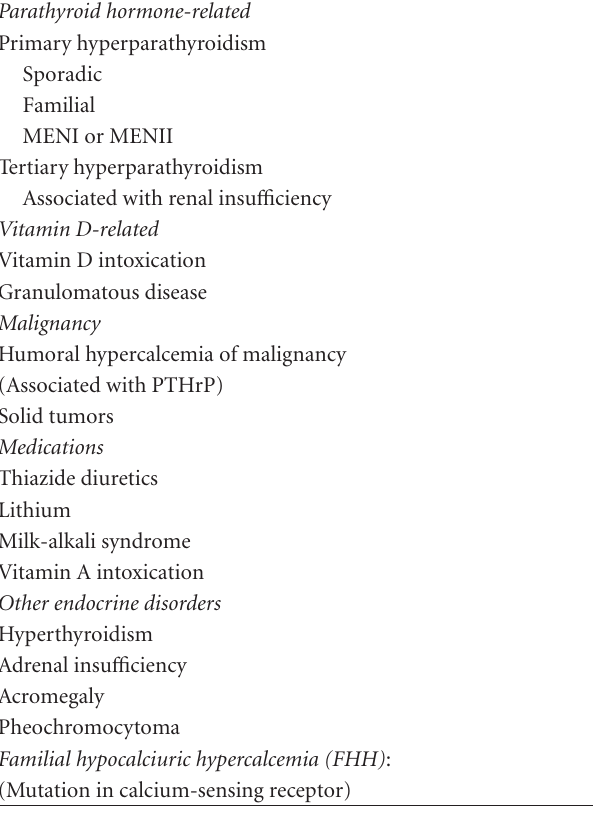
Table 3: Causes of